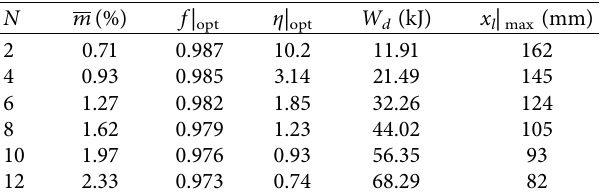
Table 4: Optimal 0.5 b w -column diameter TLWD parameters under various numbers of column N .